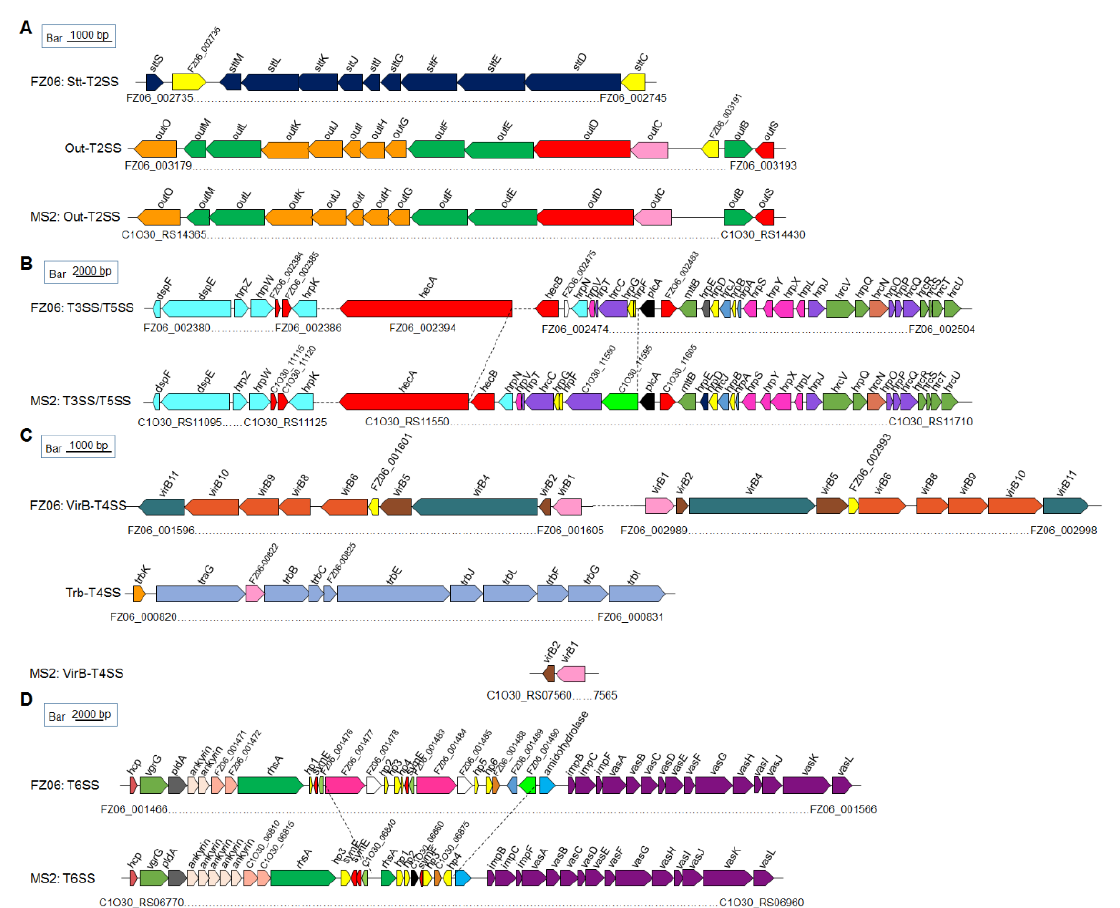
Figure 5. Genetic organization of the T2SS ( A ), T3SS and T5SS ( B ), T4SS ( C ), and T6SS ( D ) clusters in strains FZ06 and MS2. ORFs with the same color in each panel represent the same biological